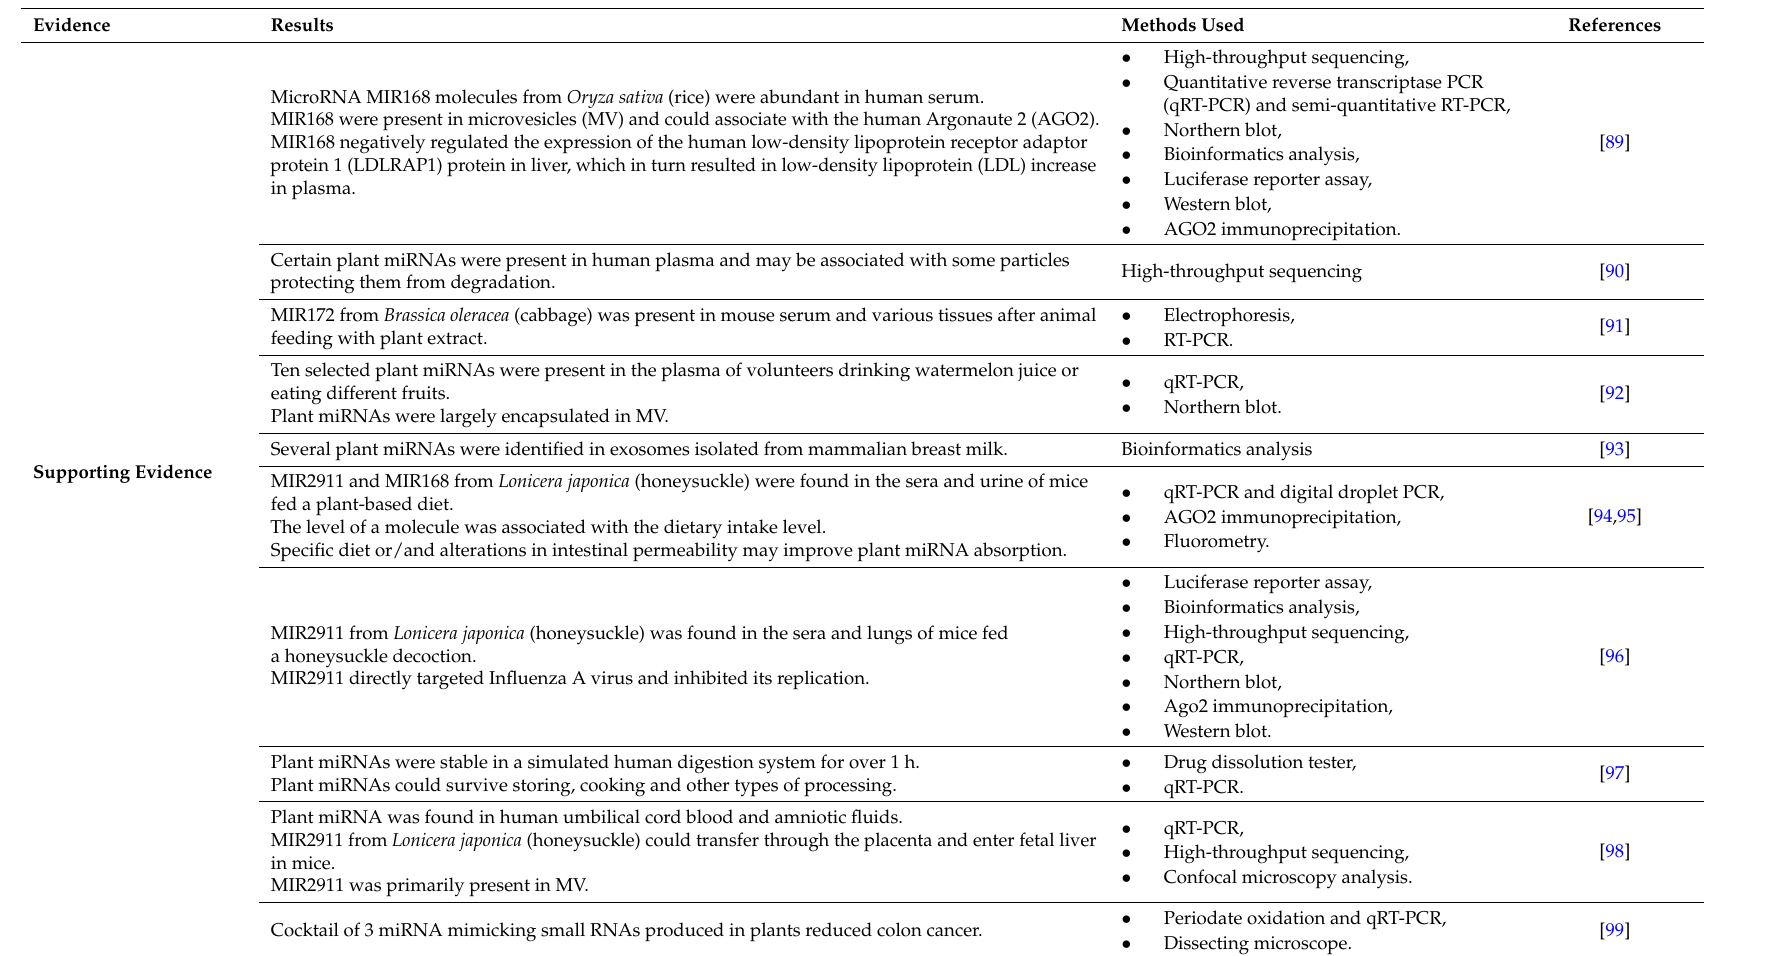
Table 1. Summary of arguments for and against the theory of cross-kingdom communication by plant microRNAs (miRNAs) presented by recent studies.